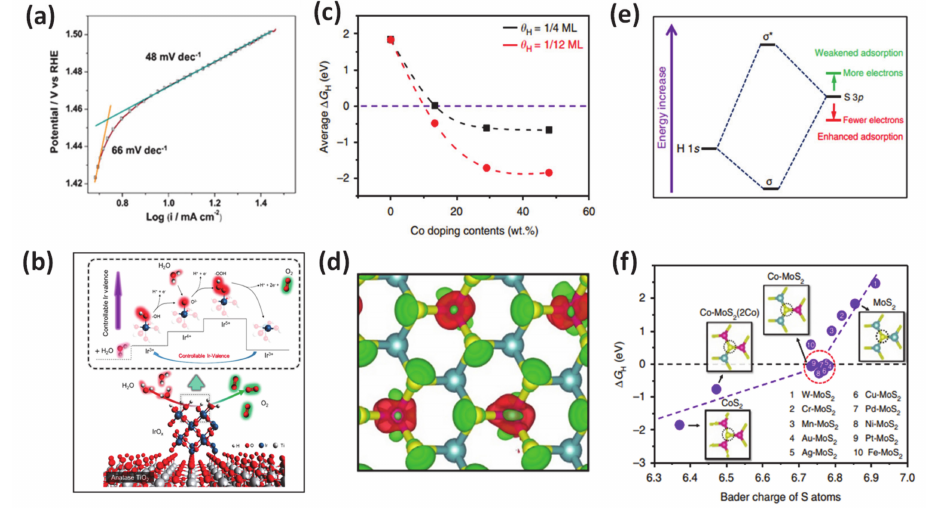
Figure 7. ( a ) Oxygen evolution reactions (OER) activity: Tafel plot of the IrO x -TiO 2 -Ti (ITOT) catalyst at the scan speed of 10 mV / s. ( b ) Proposed OER mechanism of ITOT catalyst. Theoretical calculations for the e ff ect of Co doping contents on HER of MoS 2 . Reproduced with permission [134]. Copyright, 2019, American Chemical Society. ( c ) Average hydrogen adsorption free energy ∆ G H on S atoms versus the Co doping contents, considering di ff erent coverage of 1 / 4 monolayer (ML) and 1 / 12 ML. ( e ) Schematic diagram of the bonding of H 1s orbital and S 3p orbital (from MoS 2 ), where depletion of electrons on S atoms will lower the orbital position and enhance the H-S bond. ( d ) The di ff erential charge density of Co-doped MoS 2 (Co doping content of 13.3 wt%, Co: Mo atomic ratio of 1:2). Red and green contours represent electron accumulation and depletion, respectively. The isosurface level is set to be 0.11 e / Bohr3. ( f ) ∆ G H on S atoms versus the Bader charge of S atoms for di ff erent structures. The insets are the atomic configurations of one S atom bonding with three Co, two Co, and one Mo, one Co, and two Mo, as well as three Mo atoms, respectively. Green balls: Mo; yellow balls: S; pink balls: Co. Reproduced with permission [131]. Copyright 2017, Springer